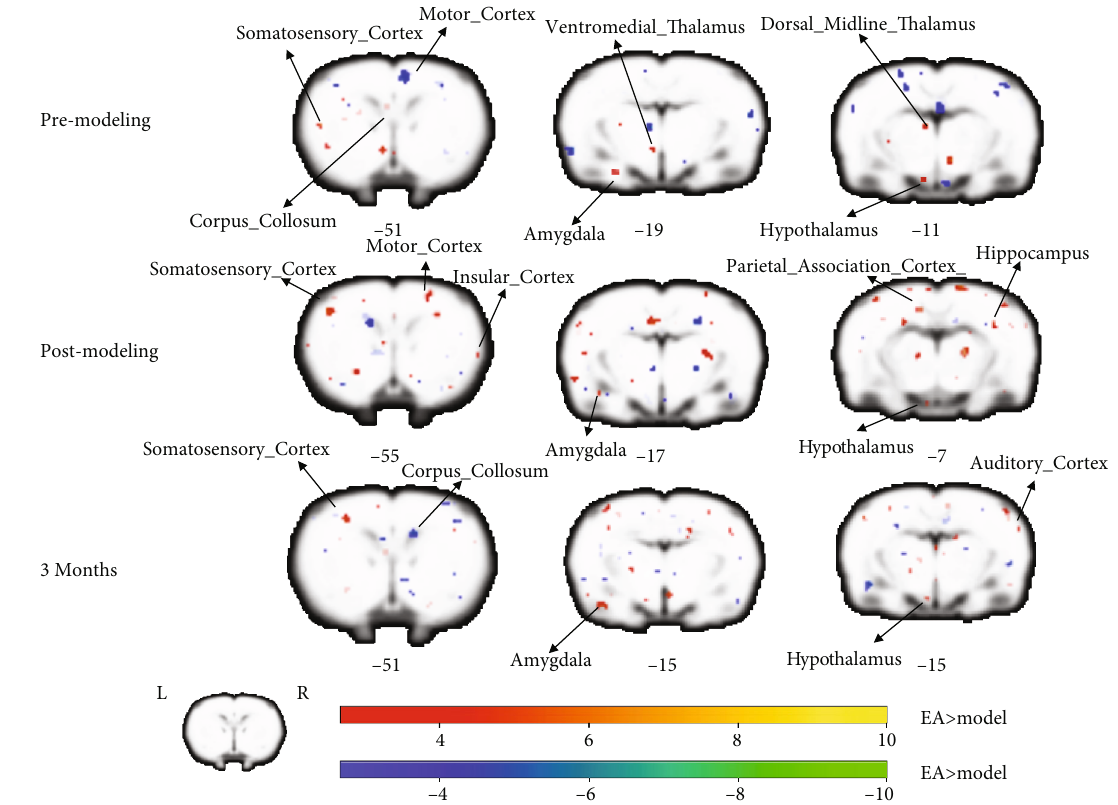
Figure 3: Group di ff erences of activation in block-design scan. The three rows displayed the results of the group di ff erence in right-forelimb stimulation task at the three time points, respectively (i.e., premodeling, postmodeling, after 3 months of treatment). The warm tone represented greater activation of the EA group than that of the model group, whereas the cold tone represented weaker activation of the EA group than the model group. The Z -value was the z -axis coordinate along the anterior-posterior axis referenced to a stereotaxic rat brain MRI template which has been aligned with the coordinates of Paxinos and Watson ’